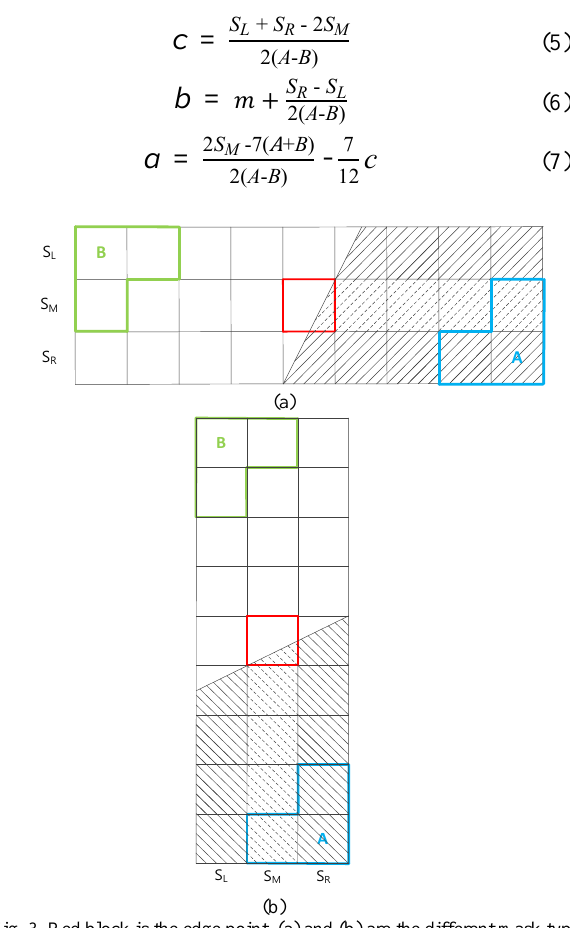
(b) Fig. 3. Red block is the edge point. (a) and (b) are the different mask type of partial area effect